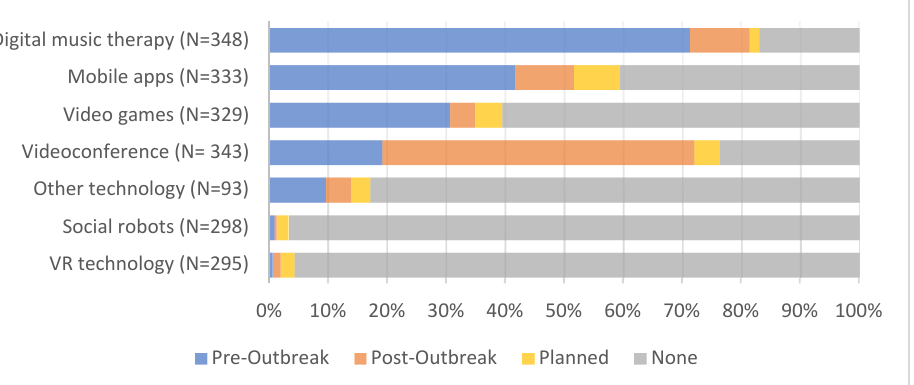
Figure 1. Utilization of digital devices to facilitate social participation for residents with dementia. Outlined are the relative frequencies of responses received per category. The pre-outbreak category includes the usage of post-outbreak (“Technology in use, even before the outbreak”).